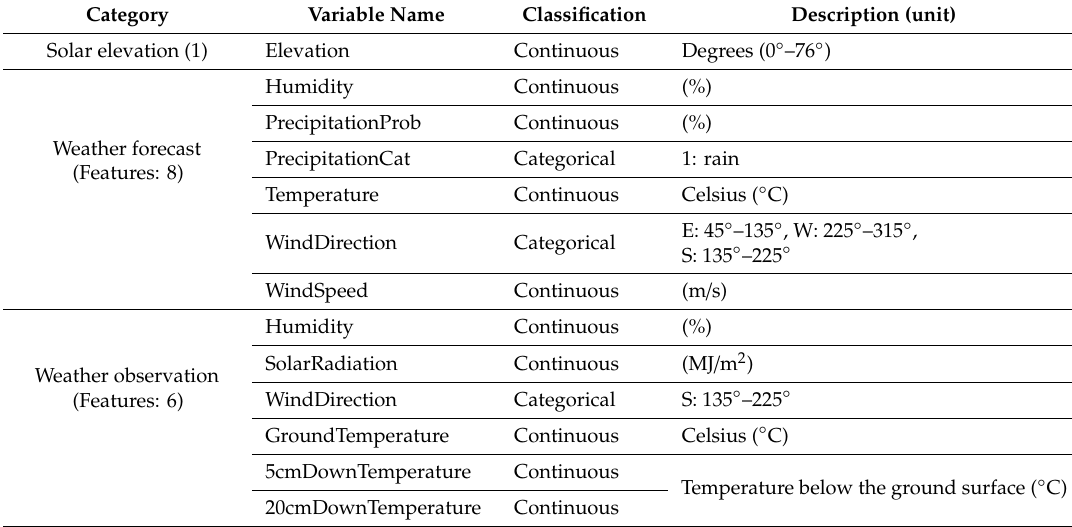
Table 9. XGboost weather